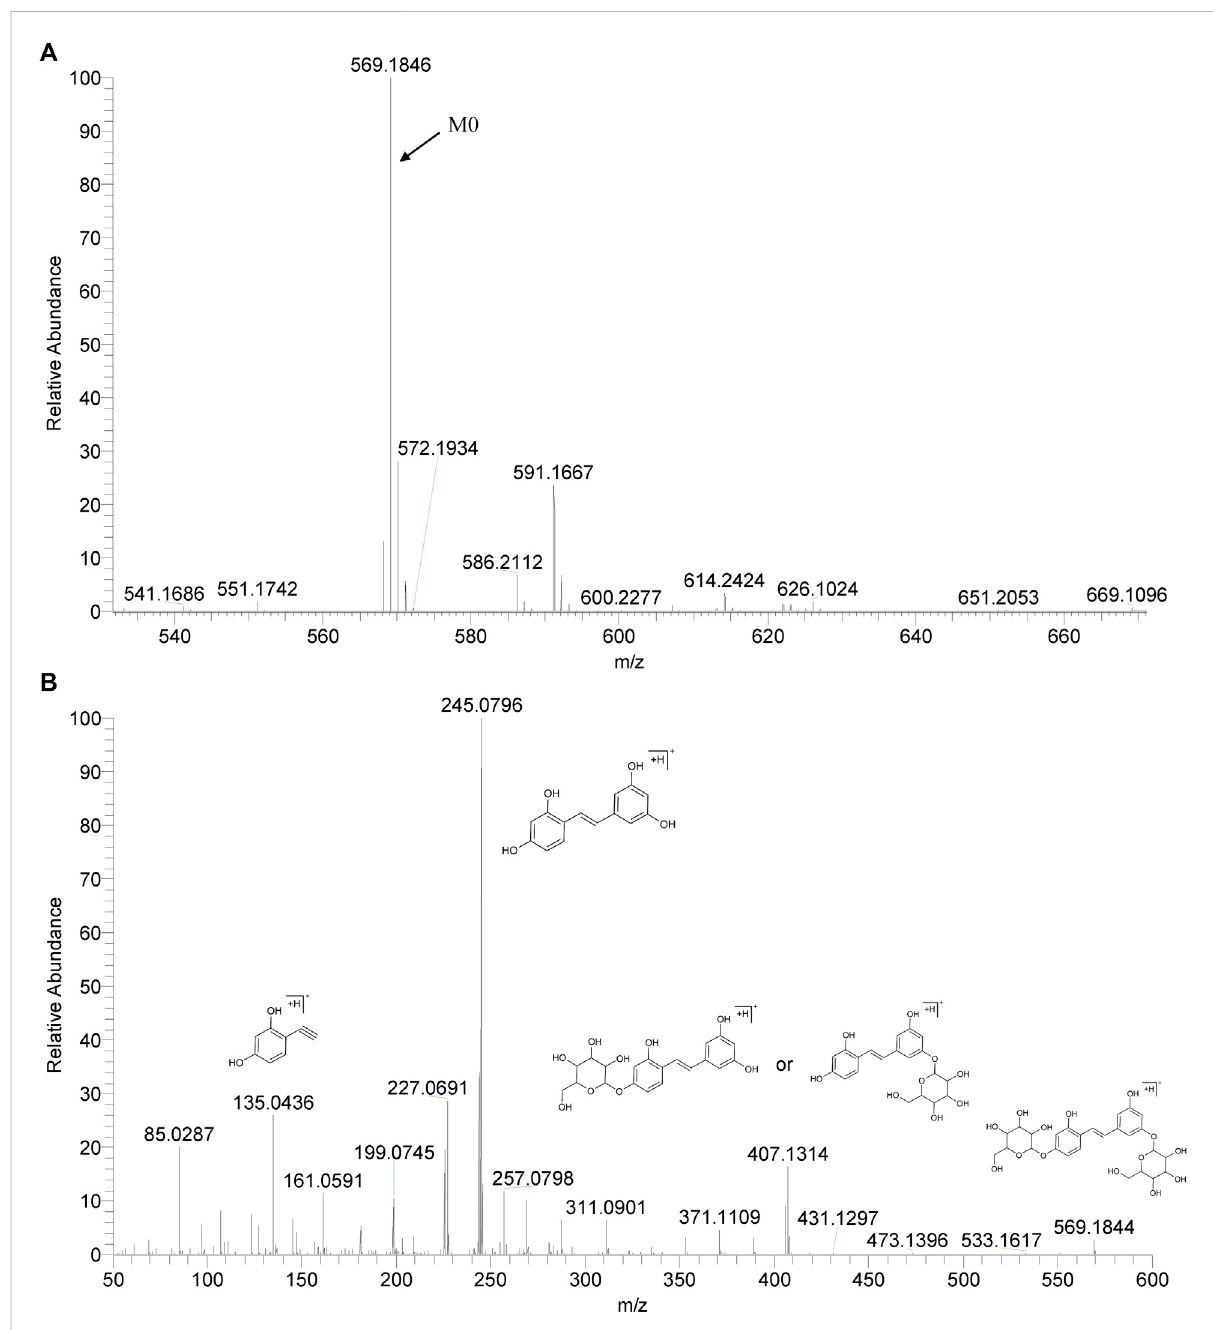
FIGURE 2 The MS (A) and MS2 (B) spectra of Mulberroside A in positive ion